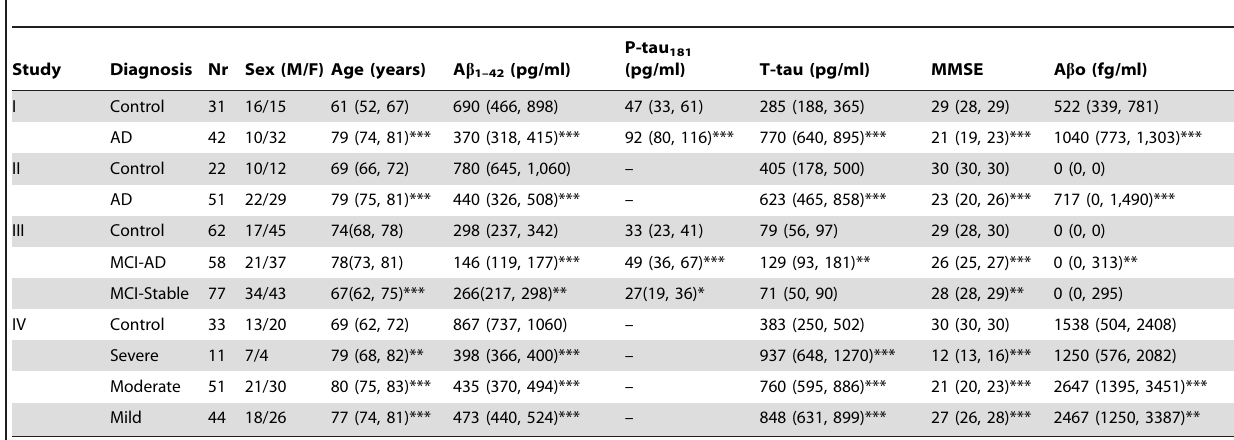
Table 1. Demographics and biomarker concentrations for all AD patients, MCI patients and